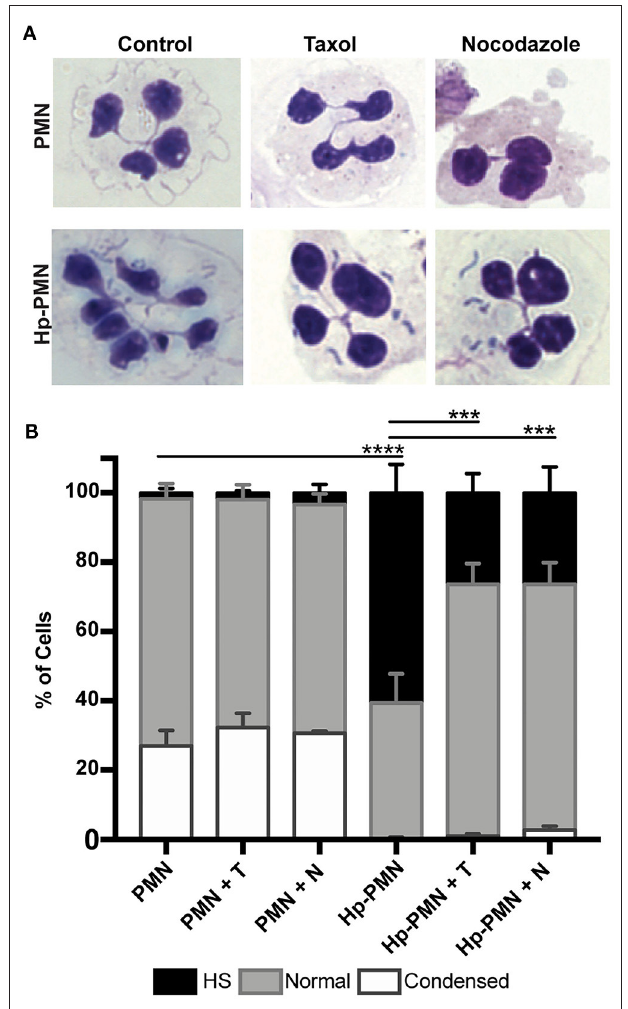
FIGURE 1 | Microtubule dynamics are required for H. pylori -induced hypersegmentation. Human PMNs were infected with H. pylori (Hp) and/or treated with taxol (T) or nocodazole (N) for 24h. Cells were attached to coverslips by cytocentrifugation and immediately stained with Hema-3 reagents. (A) Representative light microscopy images of treated and control PMNs (x1,000 original magnification). (B) Nuclei were scored as hypersegmented (HS, 5, or more lobes), normal (3-4 lobes), or condensed (1-2 lobes). Pooled data are the mean + standard error of the mean from three independent experiments. *** P ≤ 0.001 and **** P ≤ 0.0001 by two-way ANOVA with Tukey’s multiple comparison test indicate differences in